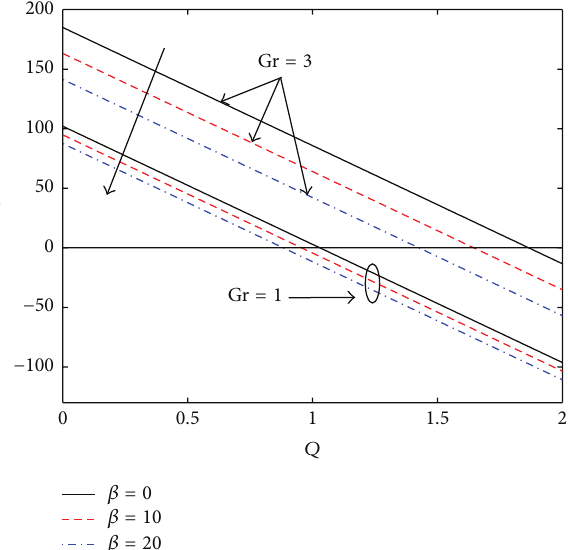
Figure 5: Pressure rise Δ𝑝 versus the time-averaged flow rate 𝑄 for different values of the heat parameter 𝛽 and the Grashof number Gr with 𝜆 1 = 1 , 𝛼 1 = 0.4 , 𝜀 = 0.35 , 𝜙 = 0.4 , and 𝑡 = 1 .